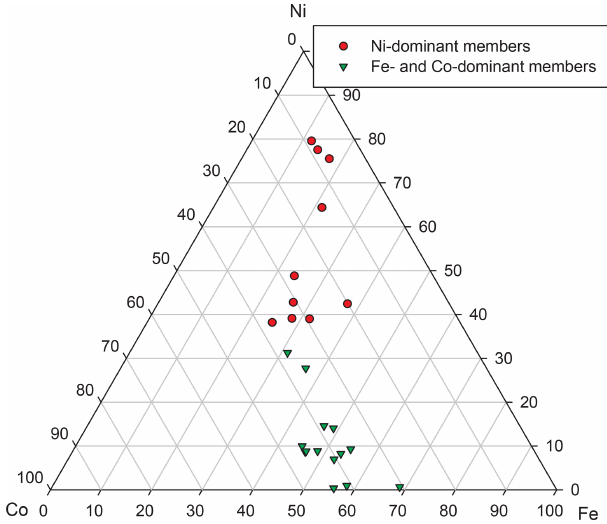
Figure 8. Ternary plot Fe–Ni–Co (at. unit) for sulfarsenides from grimmite-bearing association from P ˇ